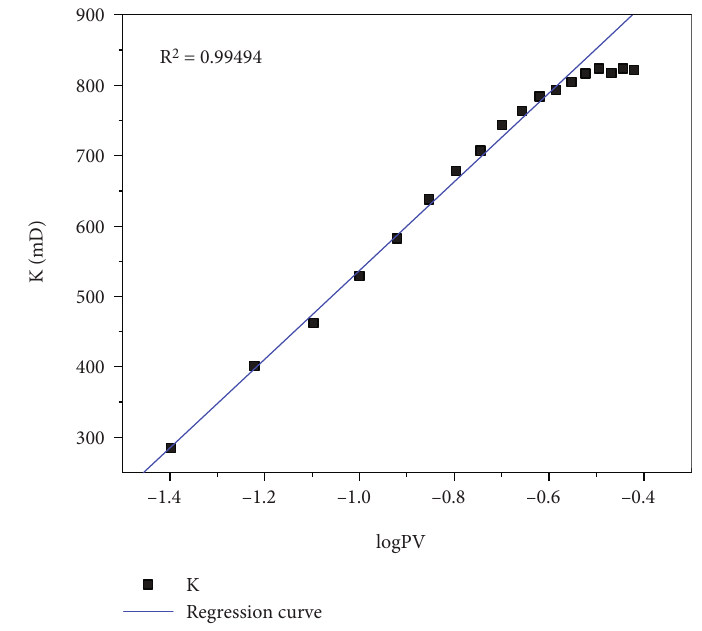
Figure 3: E ff ect of nanosolution on permeability of medium permeability